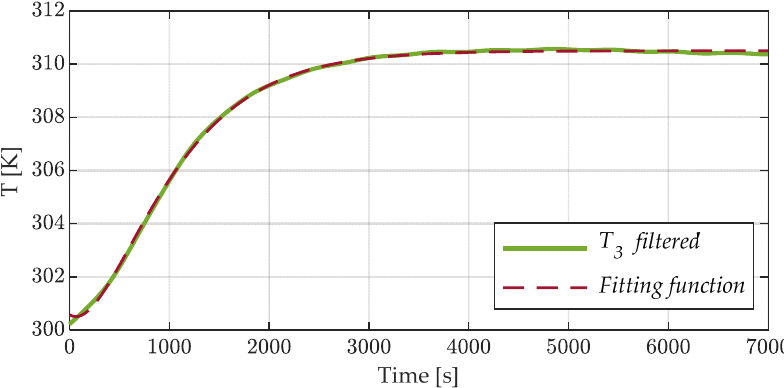
Figure 10. The value of C th is retrieved and reported in Table 4.